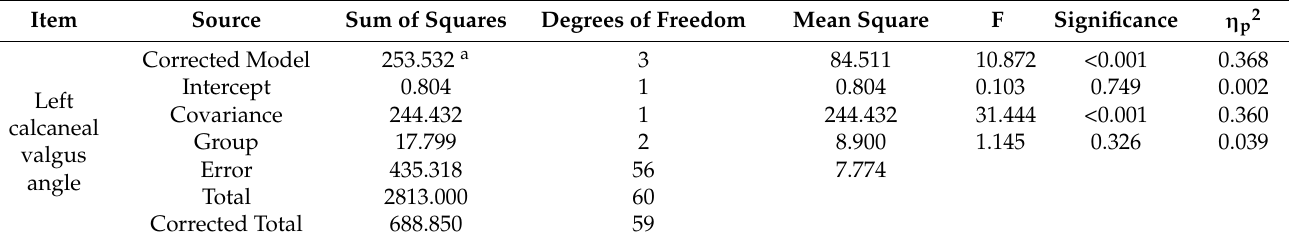
Table 10. Analysis of covariance results concerning the left calcaneal valgus